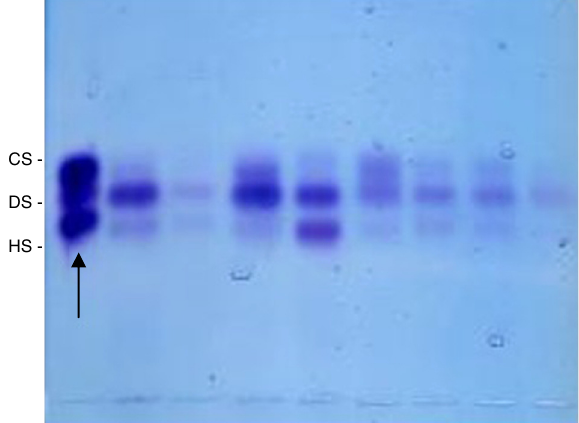
Figure 1 Bands obtained following 0.1% toluidine blue stain- ing in a solution of 1% acetic acid, and 50% ethanol and destaining with 1% acetic acid and 50% ethanol, which were quantified by densitometry. The standard is on the left of the image (arrow). CS, condroitin sulfate; DS, dermatan sulfate; HS, heparan sulfate.